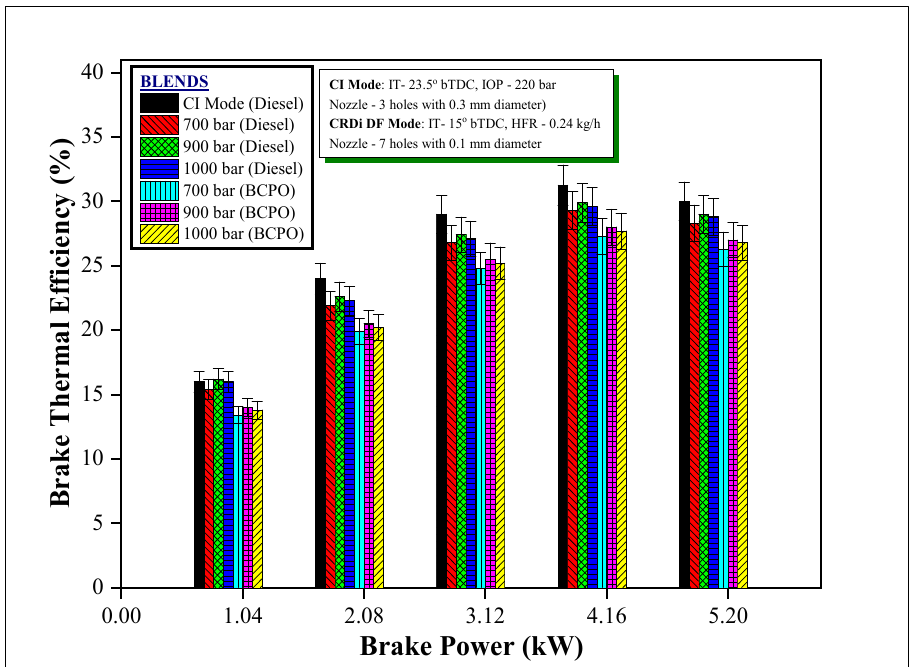
Figure 9. IP and BP influence on CRDi engine BTE.